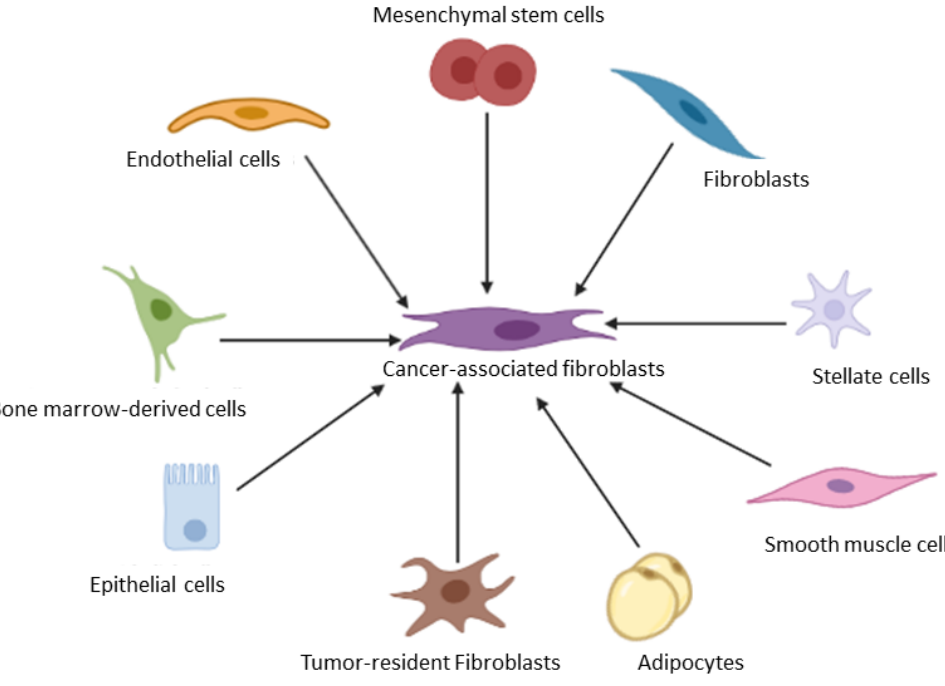
Figure 4. Cancer associated fibroblasts are diverse in origin. The origin of CAFs range from tissue resident fibroblasts, pericytes, endothelial cells to mesenchymal stem cells. Another potential origin of CAFs is epithelial cells. Epithelial cells near cancer cells